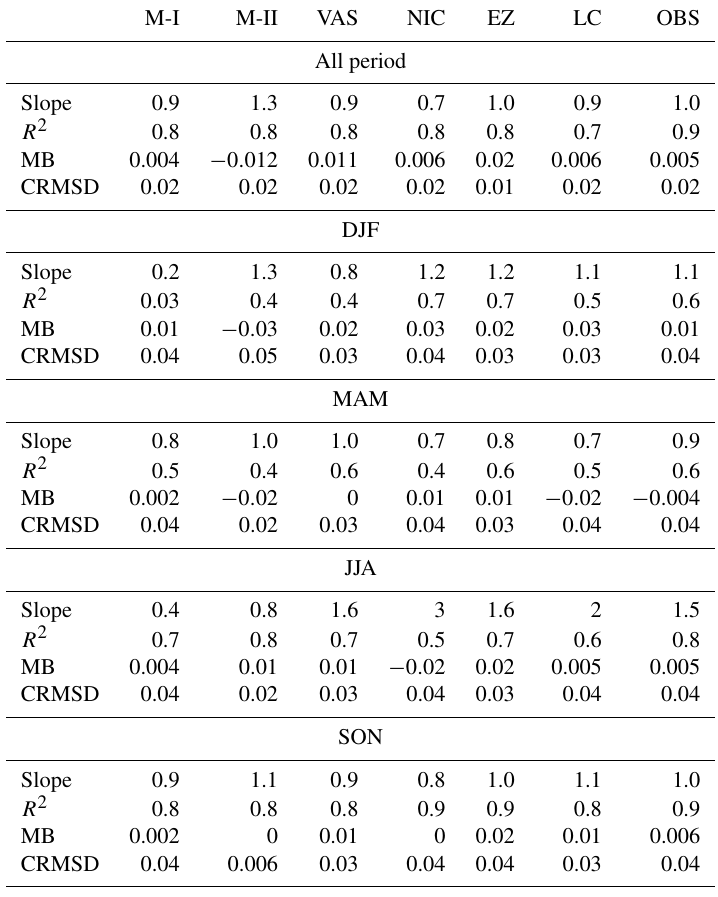
Table 4. Statistics of daily areal averages of ground-based SSM measurements in the OBS area versus point-like SURFEX (ISBA) simulations at the same sites. The acronyms for the names of the stations are as described in Table